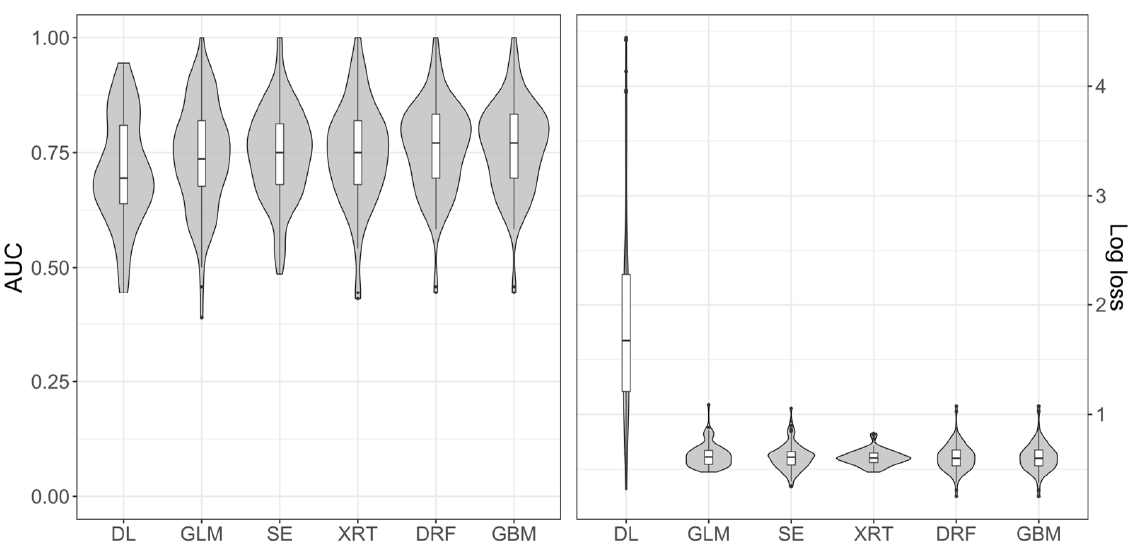
Figure 5. Validation of 100 model run for the best models of each algorithm family from AutoML run based on 2-class scenario and VSURF ‘interpretation step’ feature set. Ordered by inreasing median ‘AUC’ (left) and decreasing median Log loss (right). DL: Deep Learning, DRF: Distributed Random Forest, GBM: Gradient Boosting Machine, XRT: Extremely Randomized Trees, GLM: Generalised Linear Model, SE: Stacken Ensembles.